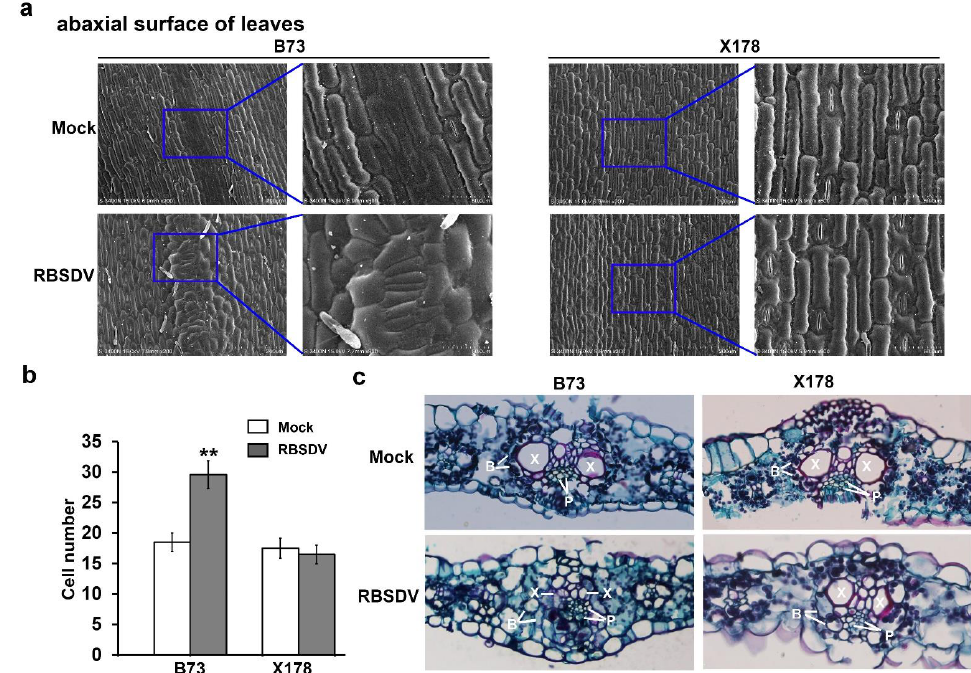
Figure 2. Microscopic structures of enations caused by RBSDV infection. ( a ) Scanning electron micrograph of abaxial surface of leaves on RBSDV-infected B73 or X178 plants and mock-inoculated B73 or X178 plants. ( b ) Statistic analysis of cell numbers of abaxial surface of leaves on RBSDV- infected B73 or X178 plants and mock-inoculated B73 or X178 plants. Three samples per treatment were used to count the number of cells. The asterisks indicate a statistically significant difference. ( c ) Micrograph of paraffin section of cross sections of leaves on RBSDV-infected B73 or X178 plants and mock- inoculated B73 or X178 plants. “B” indicates bundle sheath; “P” indicates phloem; “X” indicates xylem.